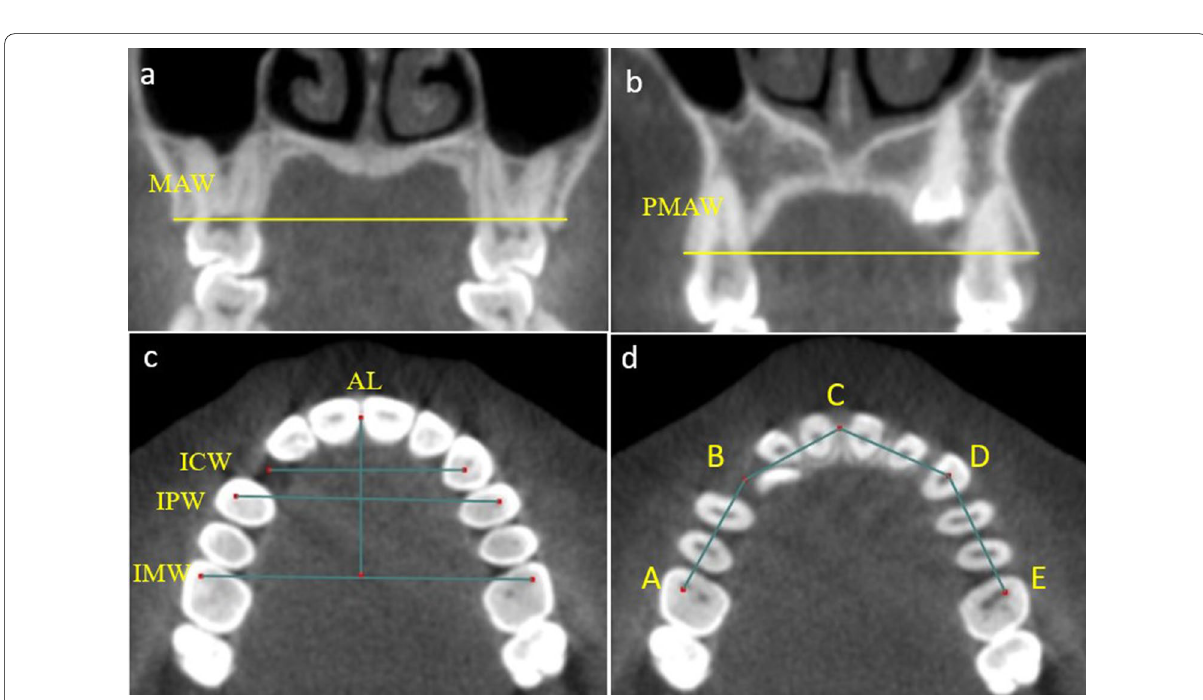
Fig. 3 The quantitative dentoalveolar measurements: a MAW, first molar alveolar width; b PMAW, first premolar alveolar width; c IMW, inter‑molar width; IPMW, inter‑premolar width; ICW, inter‑canine width; and AL, arch length; d Arch perimeter: the sum of distances A–B, B–C, C–D, and